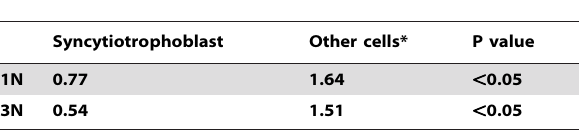
Table 2. 5-mC staining scores between the groups.